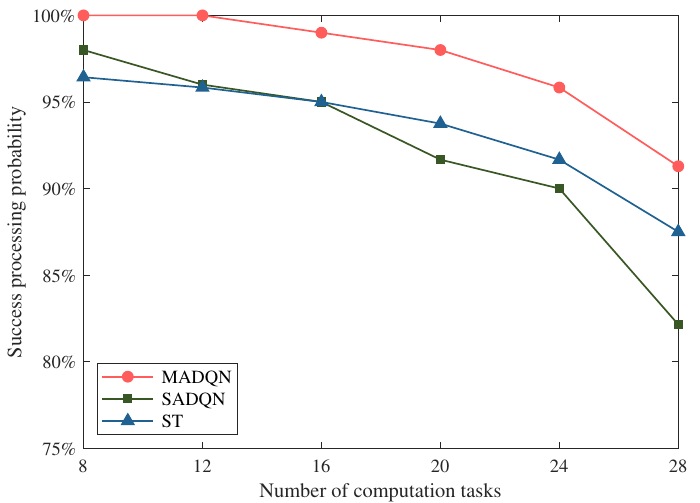
Figure 11. The effect of the number of computation tasks on the successful processing